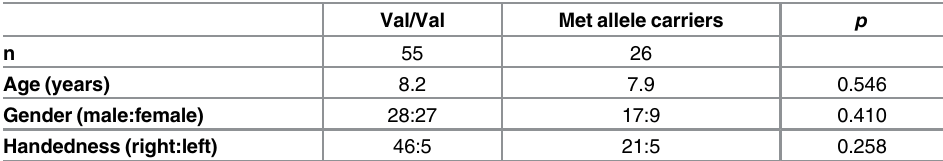
Table 1. Participant characteristics by genotype